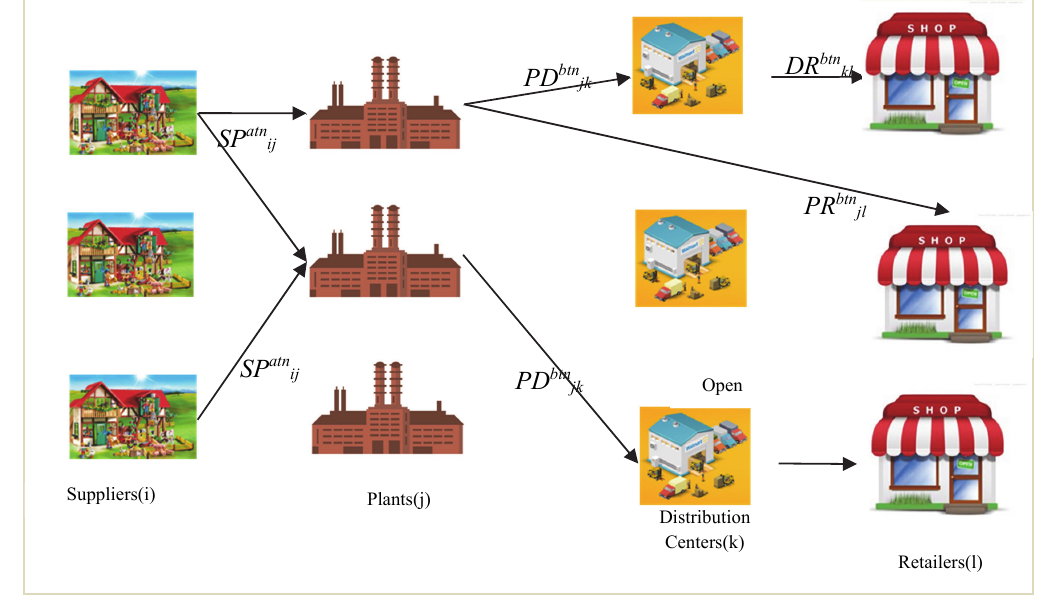
Fig. 1. The structure of the proposed supply chain network in the present